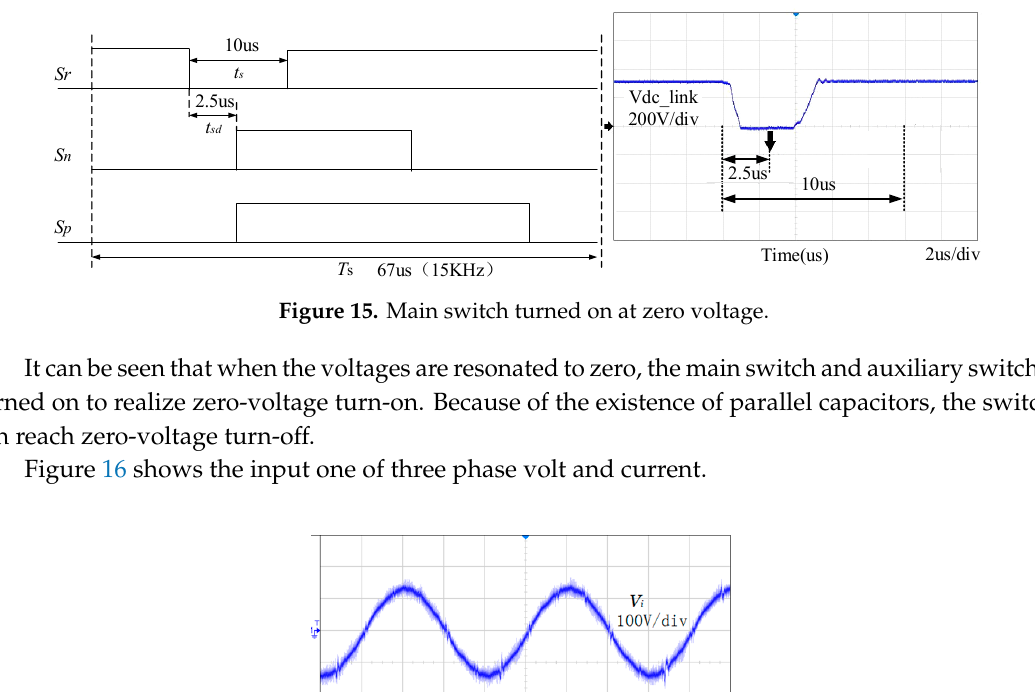
Figure 14. The voltage on the bridge arm and resonant inductance current.